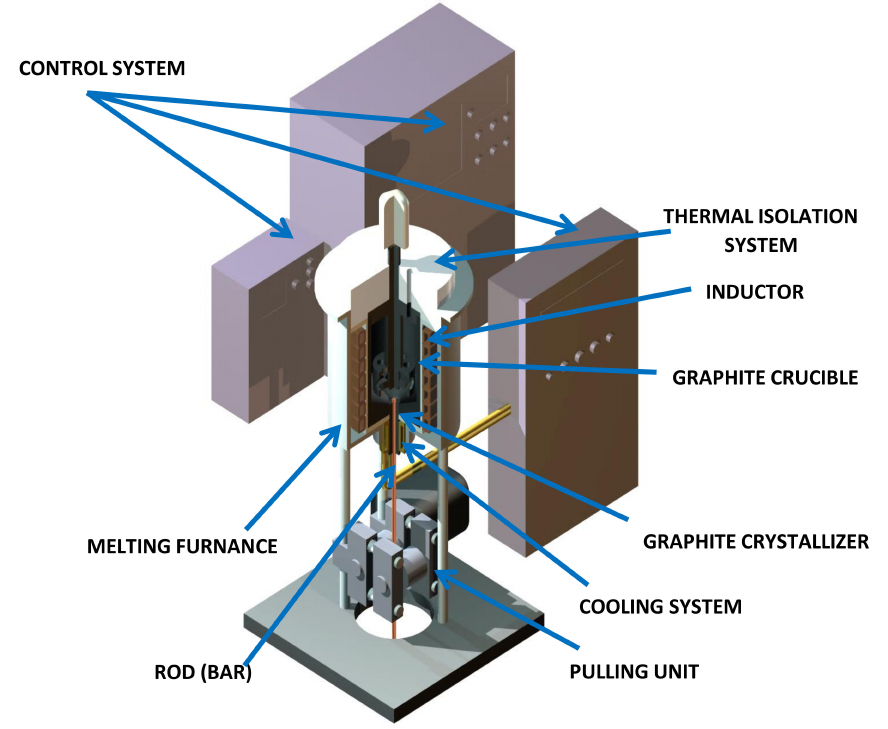
Figure 4. Schematics of the melting and casting furnace.